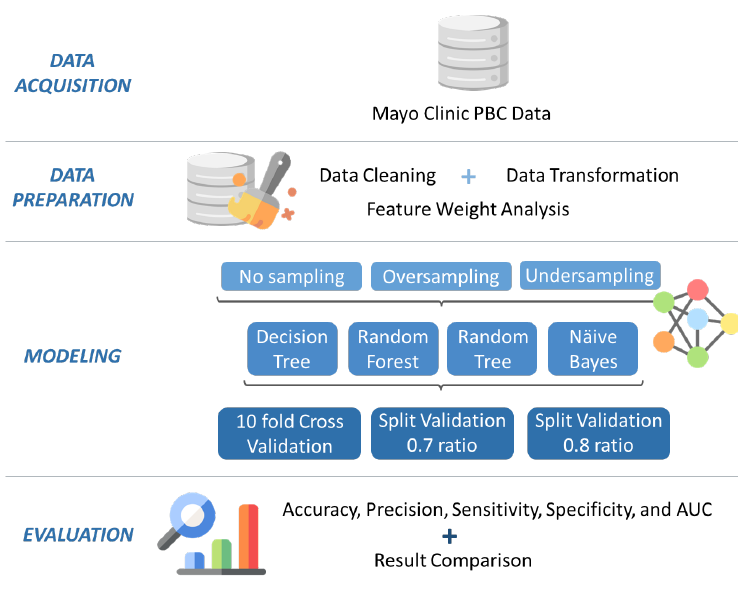
Figure 2. Project plan of steps taken in the present study.